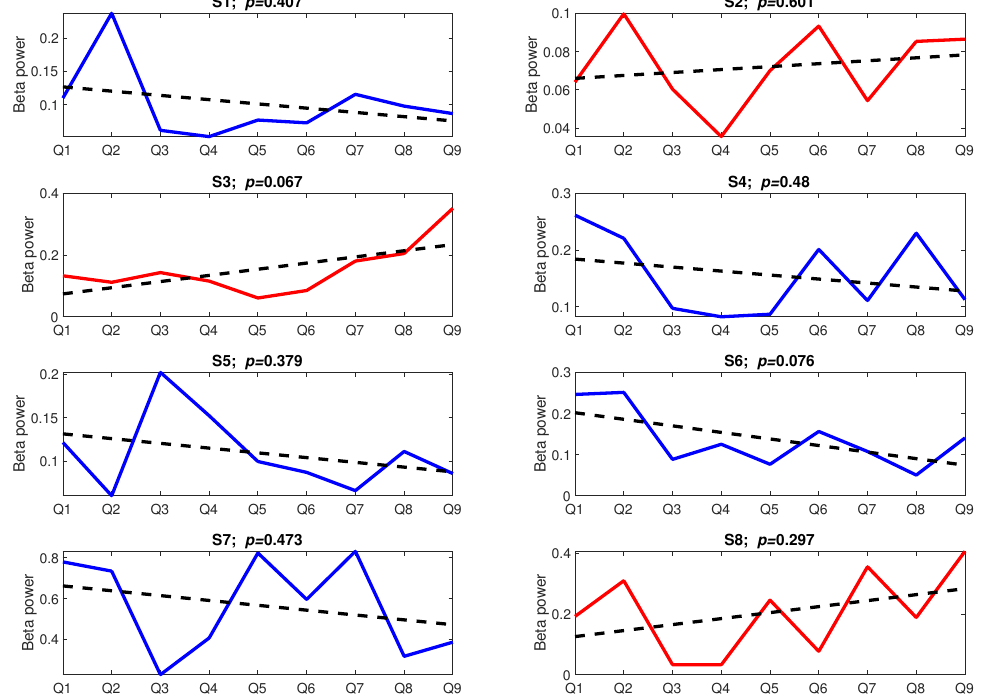
Figure 11. The stress-inducing events from Task B over time; upward trends are marked in red, downward trends are marked in blue, dotted lines present linear trends; Q: Question, S: